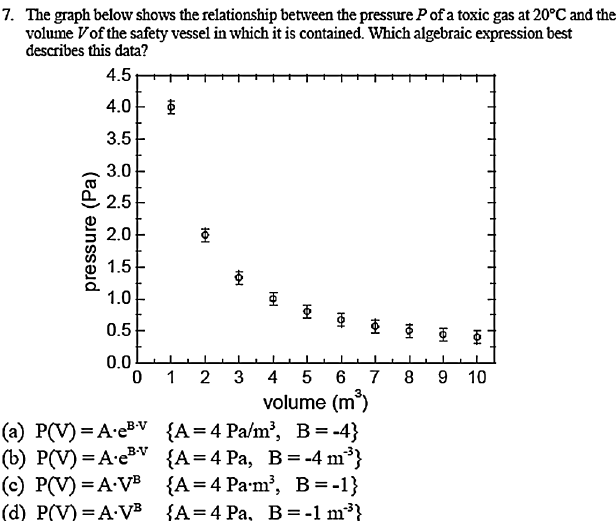
FIG. 9 (color online). Item 9 assesses both the understanding of rounding error in a digital instrument and the propagation of that error through a simple multiplication. The distractor options include (b) which arises from ignoring the uncertainty in the mass of a single rod, and then attaching an uncertainty of 0.01 mg to the meter, (c) attaches a 0.01 mg uncertainty to the initial measurement, rather than a 0.005 mg rounding uncertainty (note that some experts will do this since real meters often have instrumental uncertainty greater than the rounding error), (d) ignores uncertainty entirely, and, (e) which does not treat the rounding uncertainty